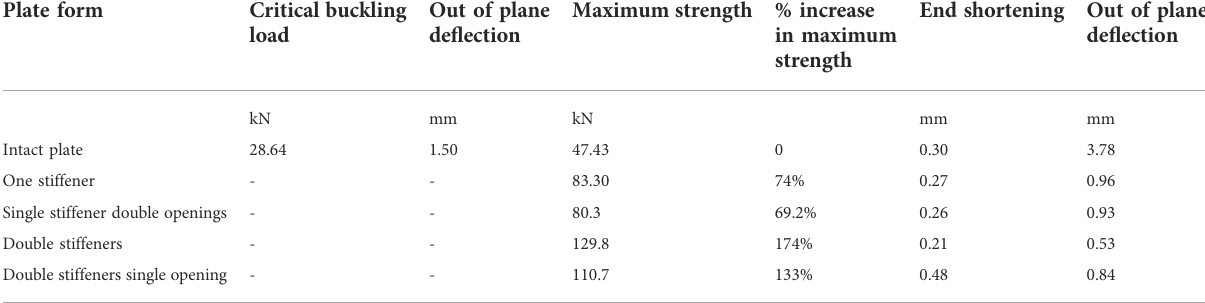
TABLE 3 Summary of analysis results for the stiffened and perforated stiffened